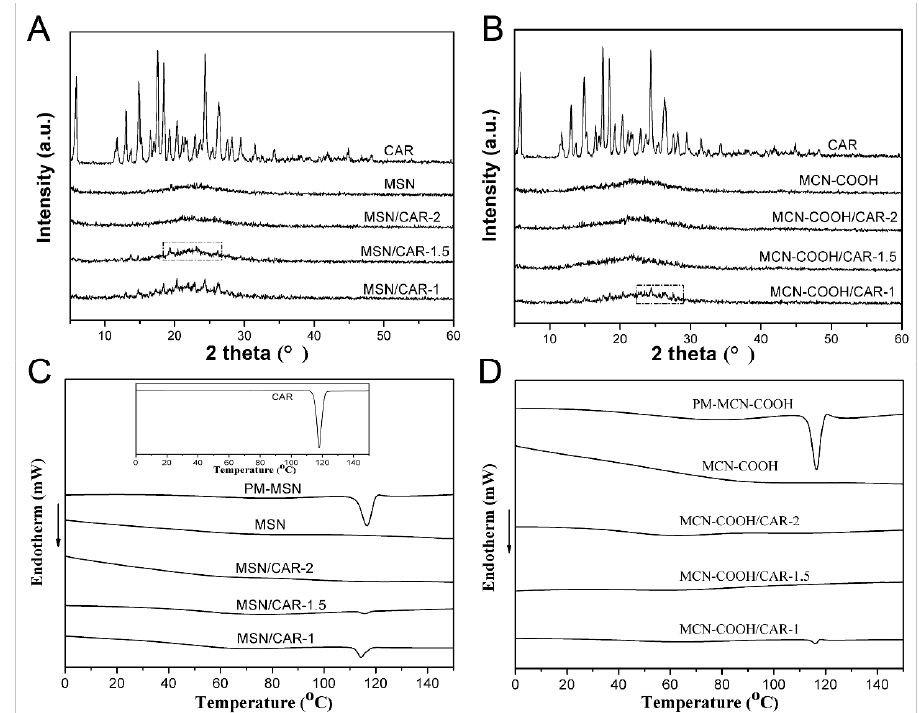
Figure 5. X-ray diffraction (XRD) patterns of ( A ) CAR, MSN, MSN/CAR–1, MSN/CAR–1.5